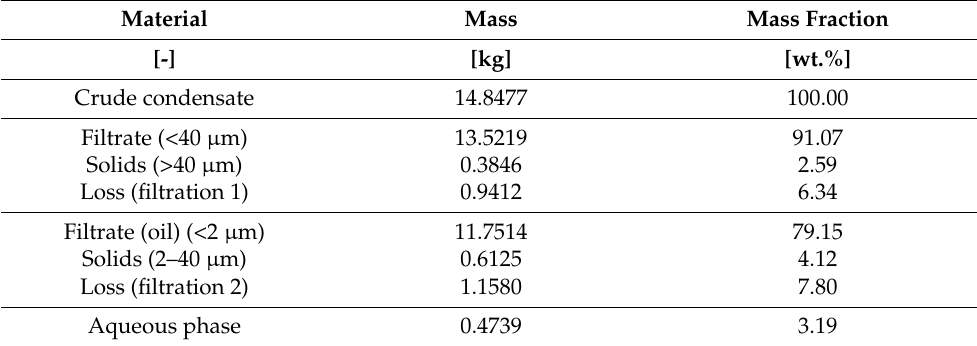
Table 3. Mass balance of condensate pretreatment.